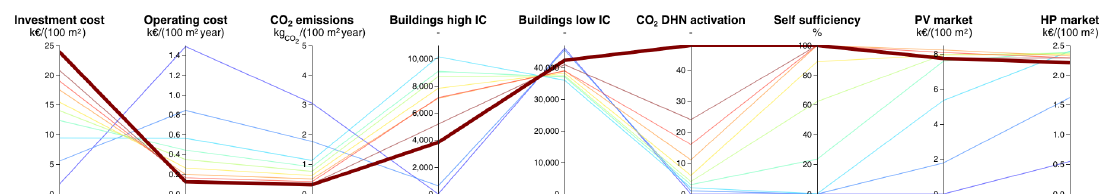
Figure 15. CO 2 network cost.